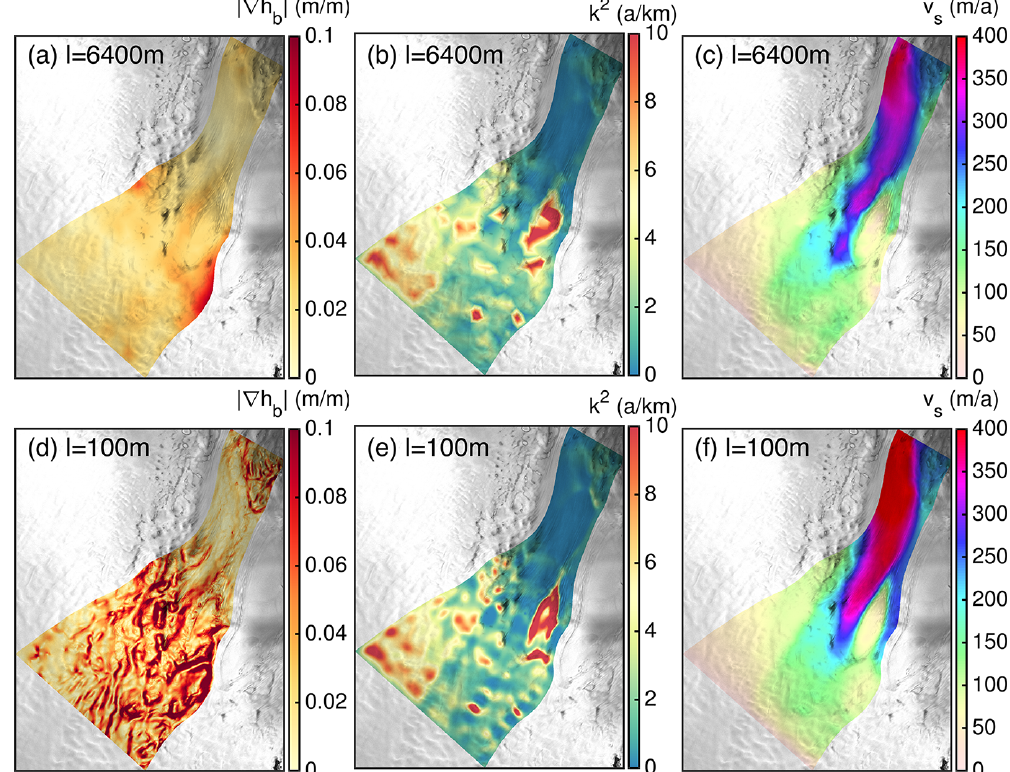
Figure 3. Overview of input parameters and exemplary simulation results of the ice-stream NEGIS region. The upper row shows slope of bed topography (a) , basal friction coefficient for E = 1 inferred with ISSM (b) and simulated surface velocity with FS, E = 1, m = 1 and with FS P1P1GLS strong (c) for 6400m horizontal resolution. The lower rows show the same fields but for 100m horizontal resolution. Background image is a RADARSAT Mosaic (Joughin, 2015; Joughin et al.,